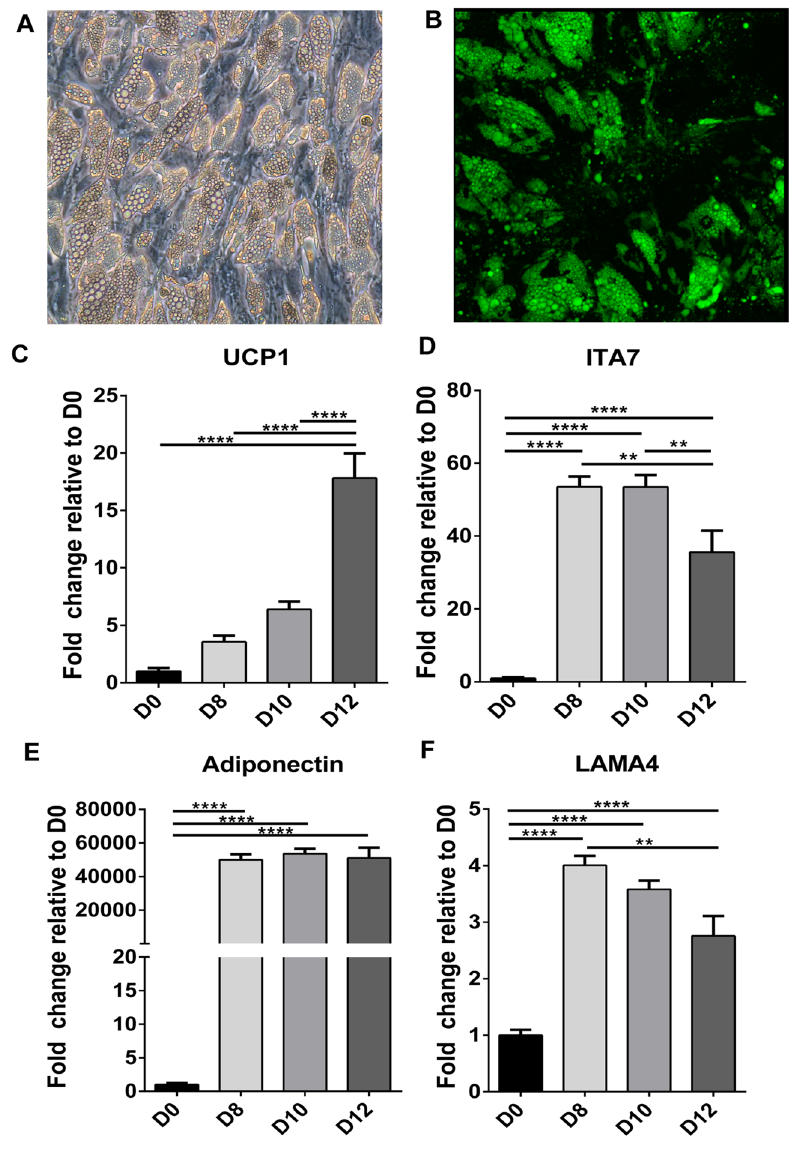
Figure 6. Timeline expression of UCP1, ITA7, Lama4 and adiponectin mRNA levels during beige differentiation of hASCs. ( A ) Representative phase microscopy picture and ( B ) fluorescent image counterstained with BODIPY, of hASCs at 12 days of differentiation. mRNAs levels of ( C ) UCP1, ( D ) ITA7, ( E ) adiponectin and ( F ) LAMA4 were evaluated in hASCs relative to D0 (undifferentiated cells) at 8 (D8), 10 (D10) and 12 (D12) days of beige differentiation.UCP1 increases with time with a significant increase at D12. At D12 ITA7 and LAMA4 had a significant decrease compared with previous days (D8 and D10). Adiponectin significantly increases between D0 and D8. Values are means ± standard errors, from one-way ANOVA analysis followed with Tukey’s multiple comparisons test. ** p < 0.01; **** p < 0.0001; n = 2 different experiments with 4 replicates per group per